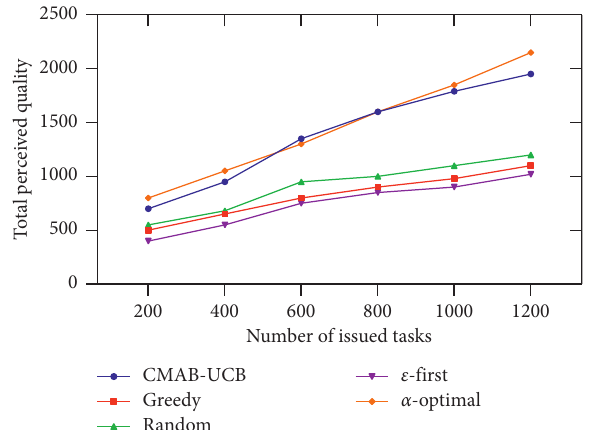
Figure 11: The relationship between perceived quality and the number of posting tasks ( b �